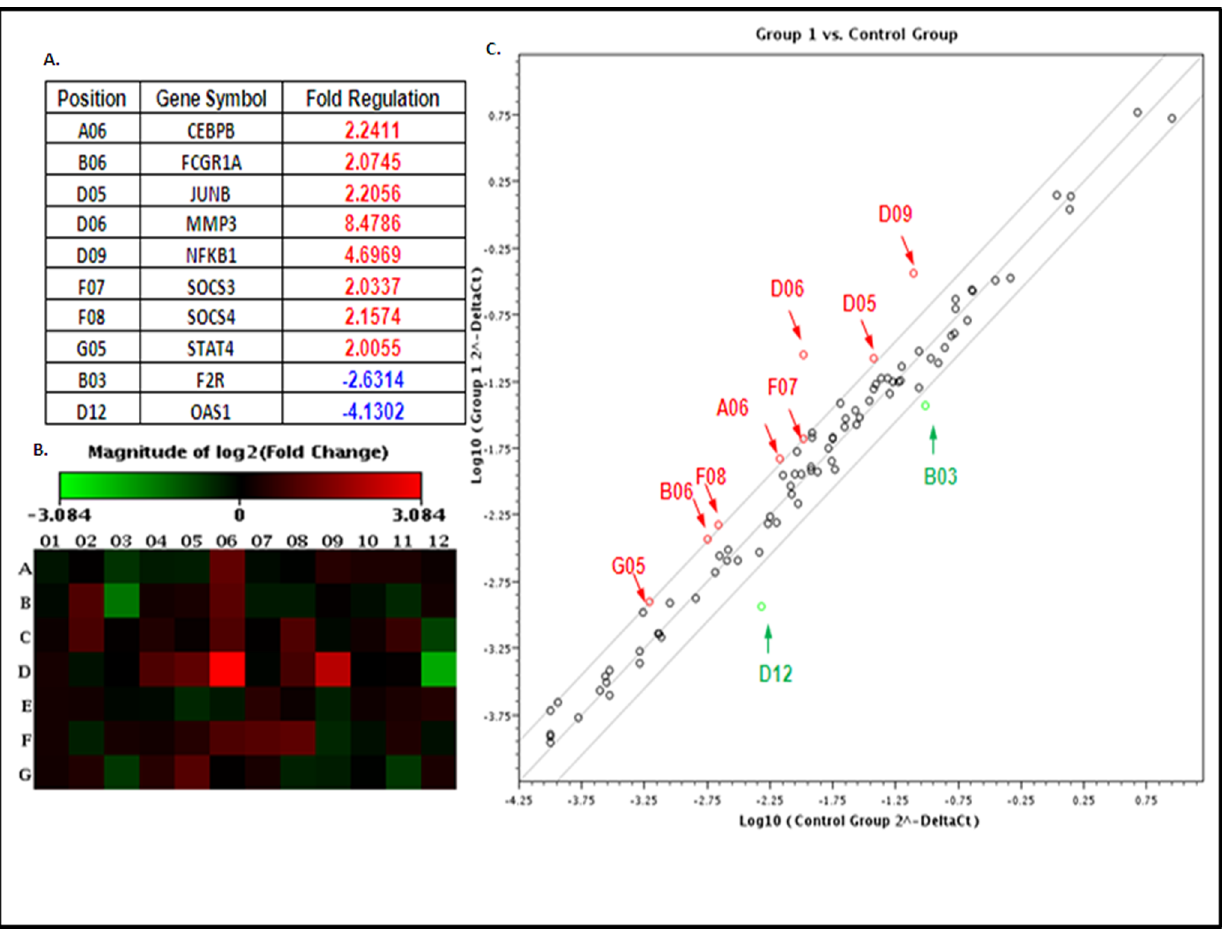
Figure 1. Human JAK/STAT signaling pathway is activated by Heme. Total RNA was extracted and cDNA was synthesized and then used to screen the human JAK/STAT signaling pathway PCR array (SABiosciences, PAHS-039A). Fold changes and p values were calculated using Student’s t- test. A p value , 0.05 and a fold change greater than 2.0 were considered to be a significant dysregulation. Figure 1A is a list of up regulated and down regulated genes with fold-change greater than 2. The heat-map (Figure 1B) and scatter plot (Figure 1C) generated are also shown.